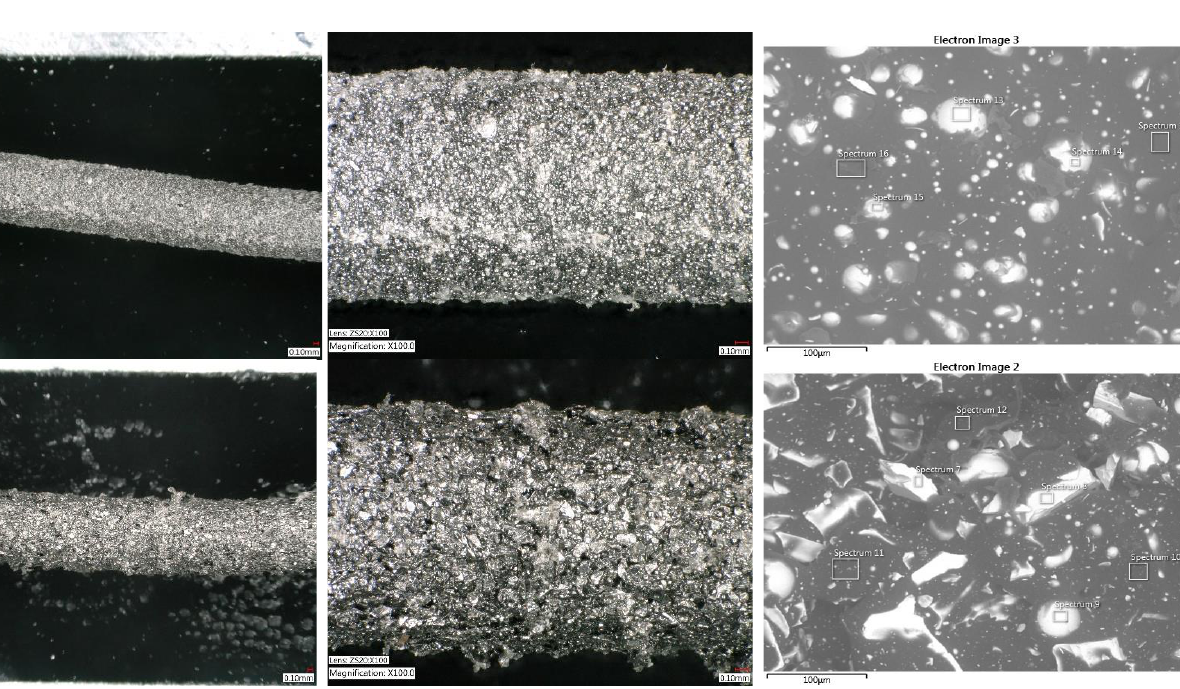
Figure 4. SEM micrographs of filament S90/10 ( a ) and filament B90/10 ( b ), showing Nd – Fe – B particles dispersed in the polymer matrix.